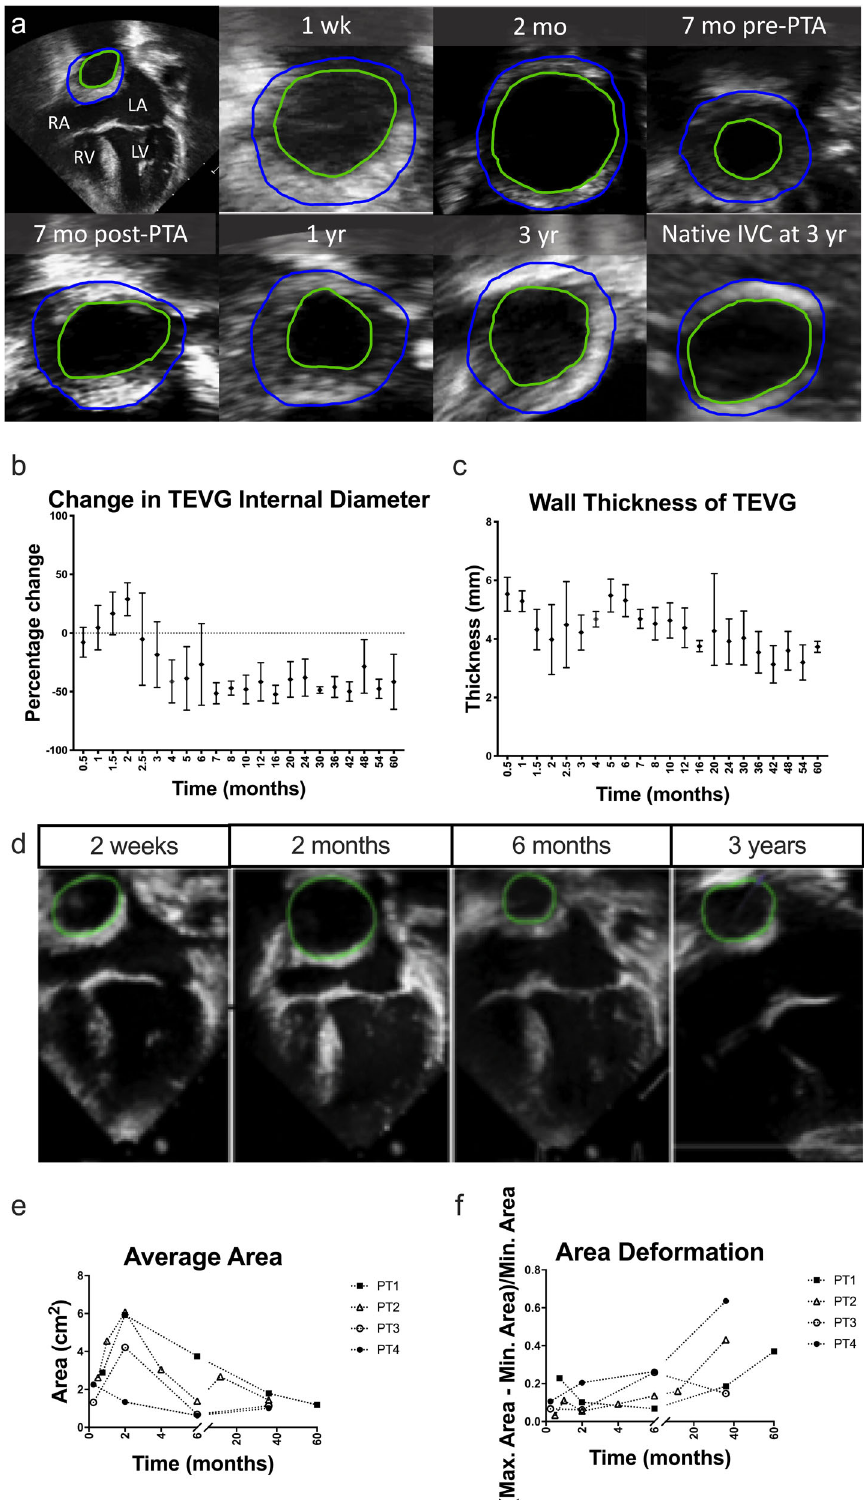
Fig. 2 Natural history of neovessel formation in clinical trial: a serial echo analysis of morphometry and biomechanics. a The internal and external circumference of the TEVG is labeled and captured in cross-section located lateral and posterior to the atrium for Patient 2 in the U.S. clinical trial. b Percent change in TEVG diameter compared to the size at implant. ( n = 4), error bars represent standard deviation. c Changes in TEVG thickness. ( n = 4), error bars represent standard deviation. d Example images of serial changes in TEVG area for PT2 from the clinical trial. e Absolute change in area. f Graft stiffness over time for all four patients in the clinical trial. PTA percutaneous